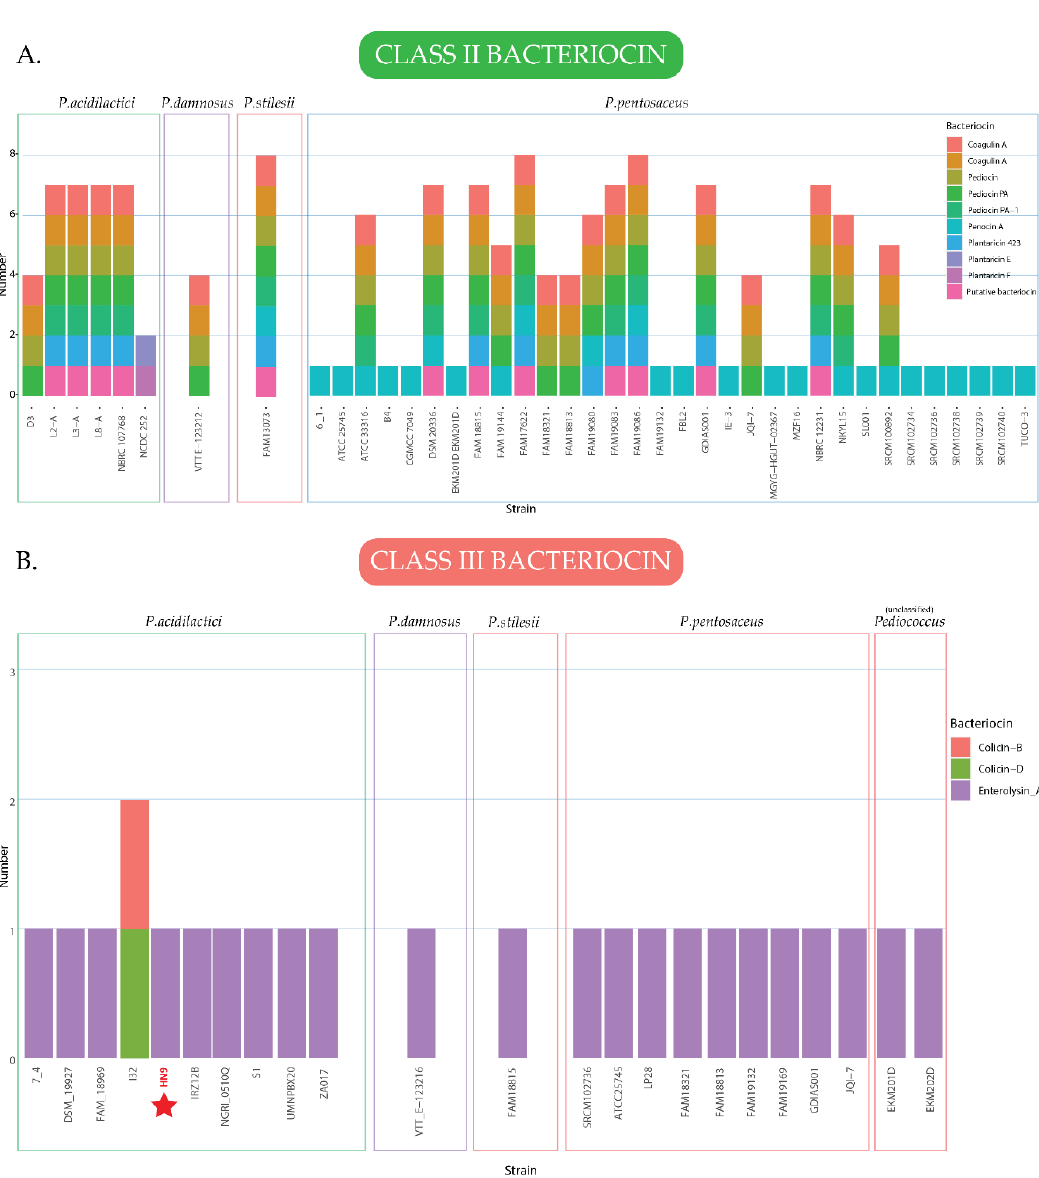
Figure 6. Identification of bacteriocin-encoding genes from all bacterial strains in the genus Pediococcus using BLASTX analysis against BAGEL4 database in (A) class II and (B) class III. The X-axis represents the name of the bacterial strain. The Y-axis represents the total number of bacteriocin identified in each strain. The different colors in each bar represent the different bacteriocins found in each strain, and the rectangle boxes represent the diversity of bacteriocin encoded in different genus. The red star indicates the location of P. acidilactici HN9 .